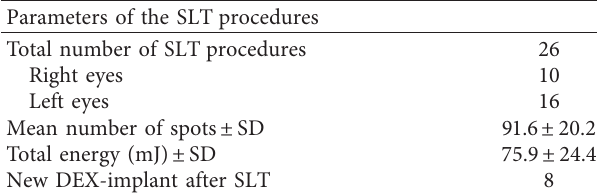
Table 2: Characteristics of the SLT